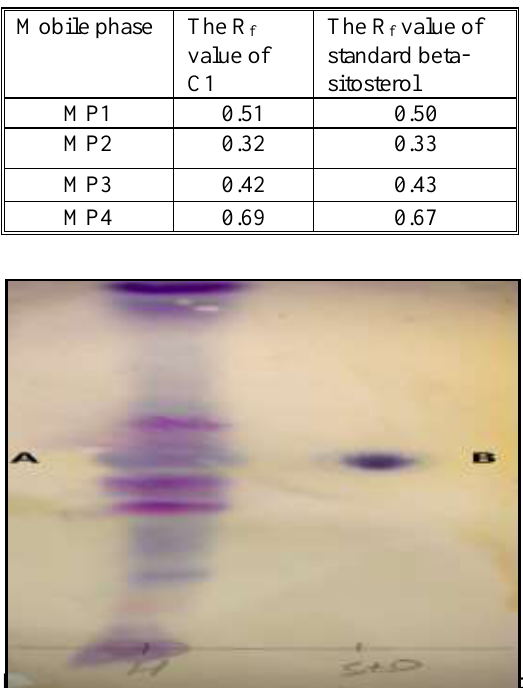
Figure1.Analytical TLC for the hexane extract and beta-sitosterol using MP1 solvent system:(A) C1 spot, (B) standard beta-sitosterol